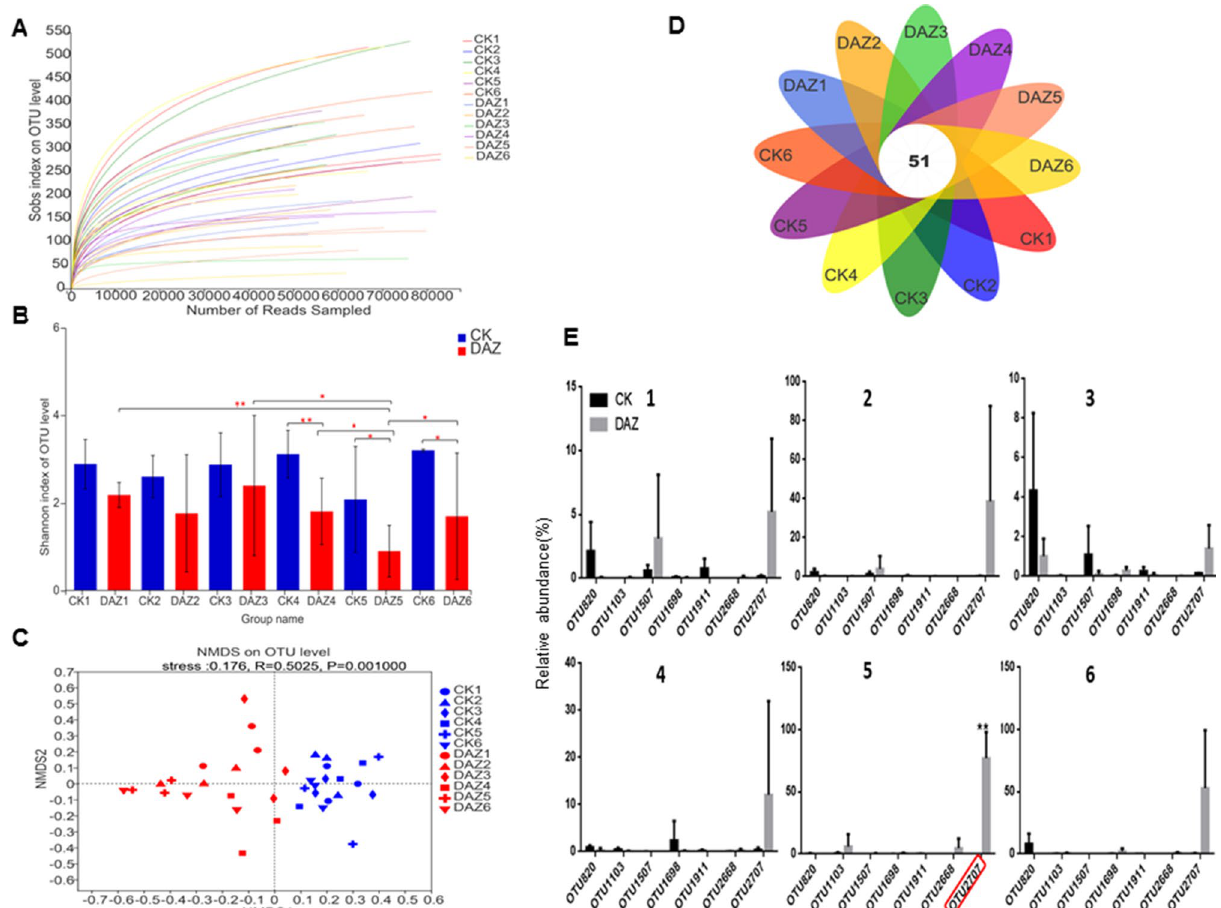
Figure 5. Bioinformatic analysis of fungal OTUs. ( A ) The rarefaction curve of the sequencing data. Draw the curve with the extracted data volume as the abscissa and the sobs index value as the ordinate. ( B ) Significant test of OTU Shannon index between treatments for every sampling time. Data are expressed as the means ± SD (n = 3). * 0.01 < P ≤ 0.05. ( C ) NMDS to compare the fungal community structure between treatments for every sampling time. Dots of different colors or shapes represent different groups of samples. ( D ) Venn diagram to display the number of core OTUs in all sampling groups. ( E ) Significance of core OTUs between treatments for every sampling time by student’s t test. DAZ dazomet treatment, CK control. Numbers after letters indicate different sampling times. 1 (March 6th, 2018, before dazomet treatment), 2 (April 24th, 2018, watermelon seedling stage), 3 (May 3rd, 2018, Fusarium wilt symptom appearance), 4 (March 6th, 2019, before dazomet treatment), 5 (April 22th, 2019, watermelon seedling stage), 6 (April 29th, 2019, Fusarium wilt symptom